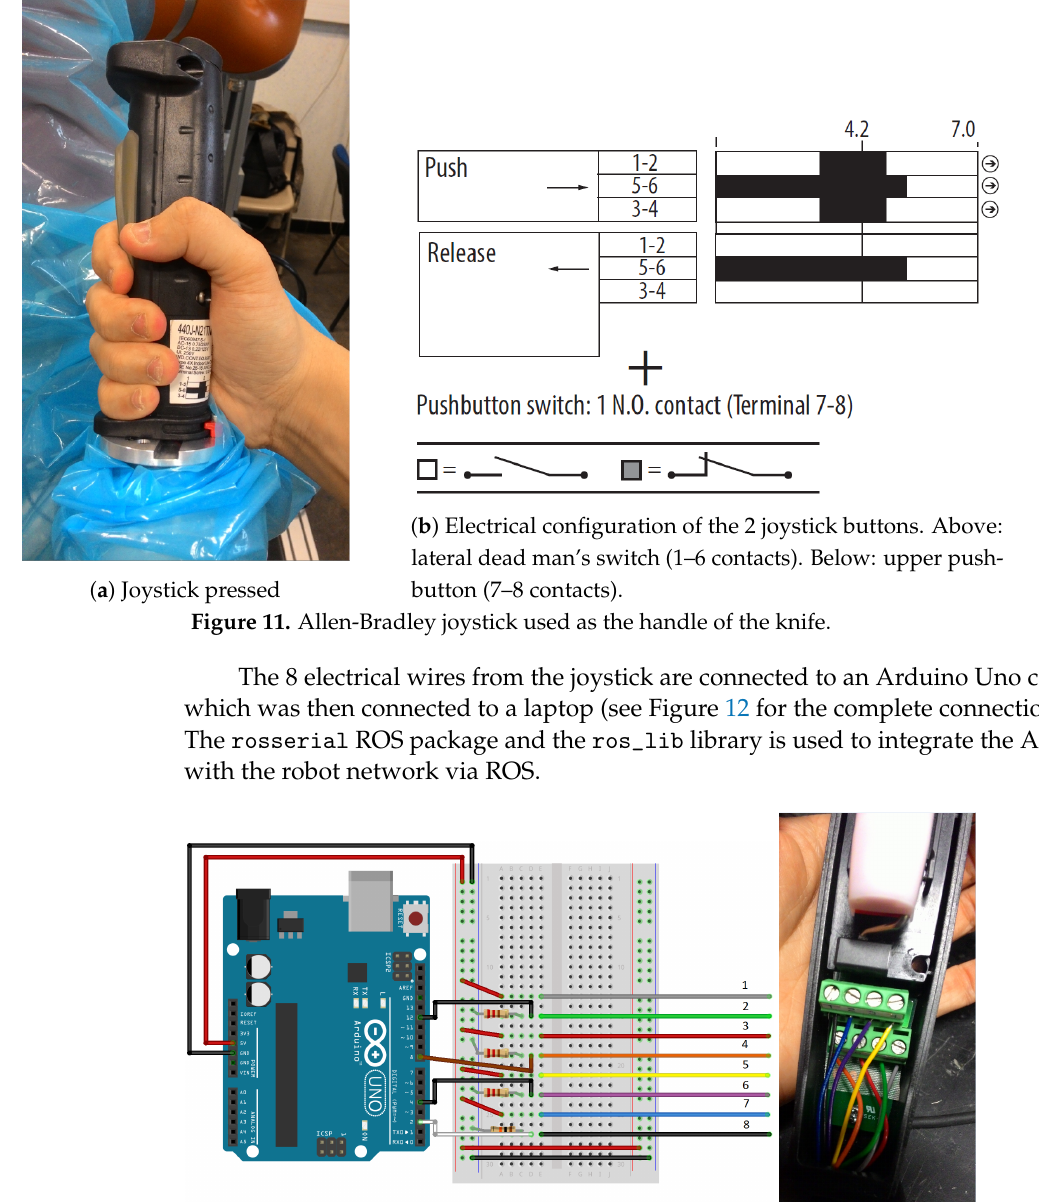
Figure 12. Arduino circuit diagram for connecting the joystick to a